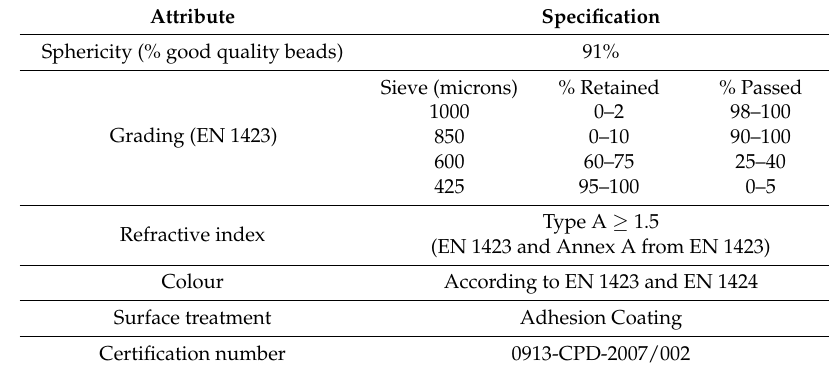
Table 6. Duolux 125 H1 glass microbeads specifications.